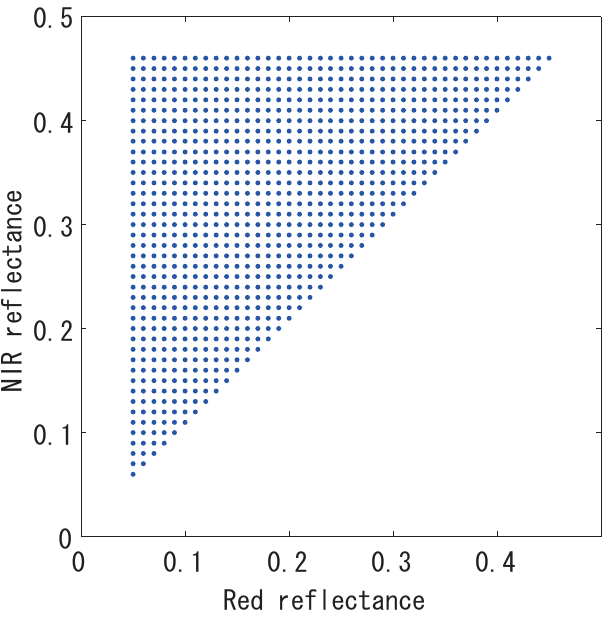
Figure 8. Target spectra over the red-NIR reflectance space used in the numerical